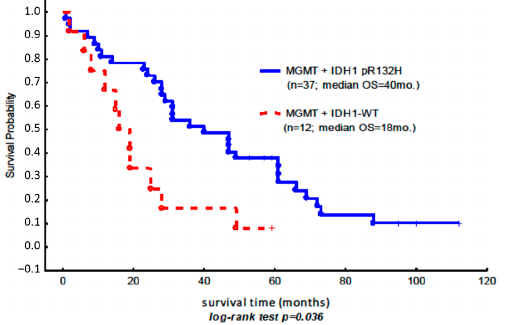
Figure 1. Kaplan–Meier overall survival curves for the subgroup of patients with MGMT promoter methylation, in which the assessment of the methylation status based on the comparison between the methylated (M) and unmethylated (U) amplicons was equal to or higher than 1 (Table 3). The blue line shows the Kaplan–Meier overall survival curves for the subgroup of patients with the somatic mutation IDH1 p.R132H and the concurrent hypermethylation of MGMT ( n = 37 (7 + 30)); the red line indicates the methylation of MGMT ( n = 12 (7 + 5)) and the wild-type IDH1 gene (Table